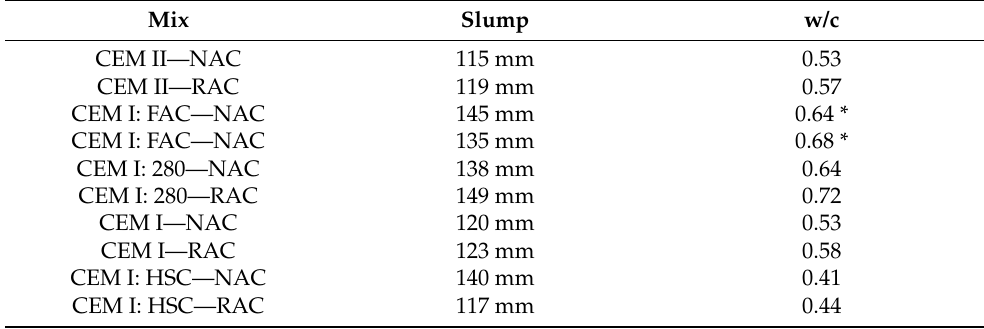
Table 3. Slump and